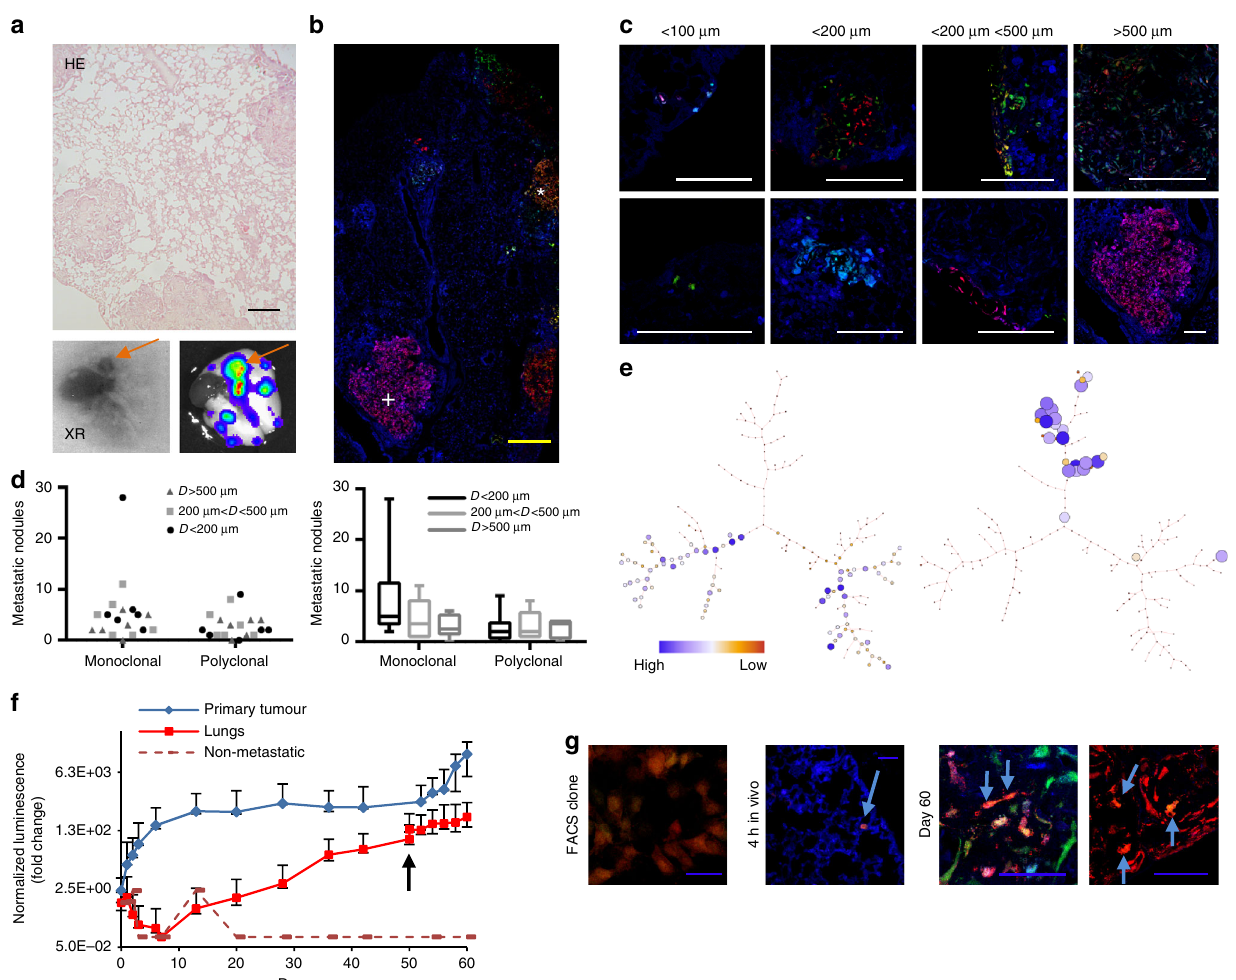
Fig. 5 RAINBONE cells generate monoclonal and polyclonal lung metastases. a Orthotopic OS tumours generated lung metastasis ( n = 5, same mice from the previous experiment) that was detected by haematoxylin/eosin staining (HE), X-ray (XR), and bioluminescent imaging. Orange arrows indicate ossi fi ed lung metastasis. b Representative image of RAINBONE lung metastases showing nodules of different colours and composition; monoclonal ( + ) and oligoclonal (*) nodules. c Representative images of oligoclonal and monoclonal nodules and size heterogeneity. d Quanti fi cation of metastatic nodules ( n = 146) according to monoclonality and polyclonality (left graph, P value = 0.0497) and further categorized depending on their size (right graph, P values = 0.396). Statistic tests: two-tail paired t -test and two-way ANOVA, Bonferroni post hoc test, CI: 95%, alpha: 0.05. P < 0.05. In boxplot graphs centre line indicates median, bounds of box indicate 25th and 75th percentiles, and whiskers indicate minimum and maximum. e Representative SPADE tree clonal composition of explanted primary tumour (left) and lung cells (right). In this case, colour represents the population frequency. f Bioluminescent in vivo growth quanti fi cation of primary tumours ( n = 5, new experimental group) and lung metastases ( n = 4). One animal did not develop metastatic disease (dotted line). The black arrow indicates intravenous inoculation of monoclonal FACS sorted clones in reseeding experiments (50 days). The average radiance was normalized to the bioluminescent signal 4 h after inoculation (day 0); data are presented as the means and the error bars represent the maximum and minimum values per group. g From the left to the right: representative confocal image of in vitro FACS clones, cells (blue arrows) after 4 h of i.v. inoculation, and two different reseeded metastases at day 60; for those appearing in colour, a further colocalization study was performed. Yellow bar = 500 µ m; white bar = 200 µ m; blue bar = 50 µ